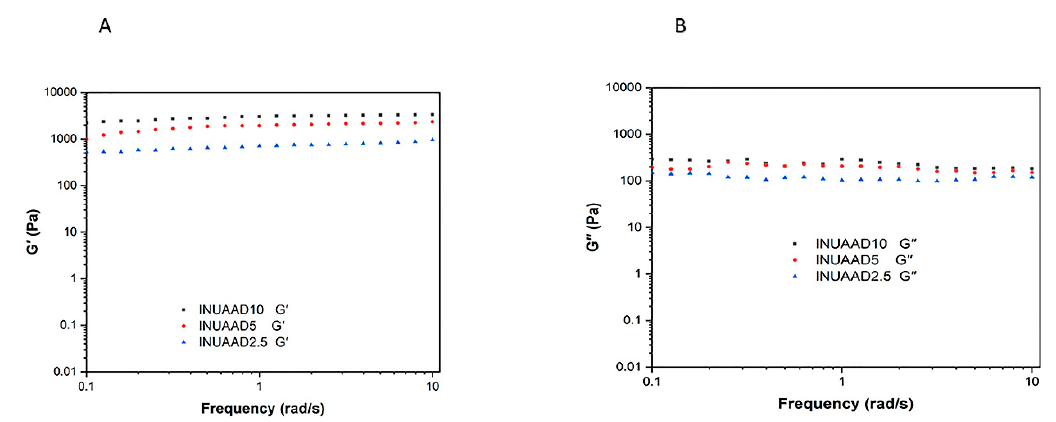
Figure 6. ( A ) Rheological properties of the INUAAD hydrogels showing the storage moduli (G ′ ) and ( B ) the loss moduli (G”) of the different crosslinked inulin hydrogels.